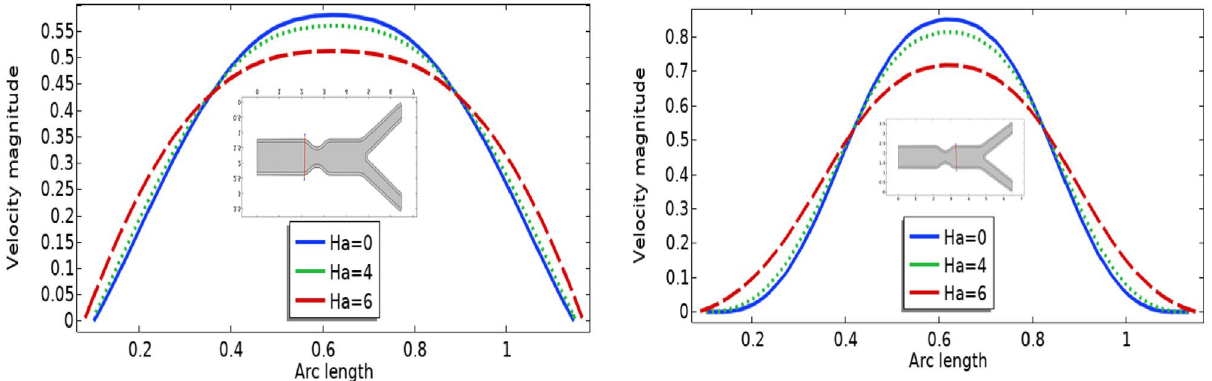
Figure 8. Velocity profile for different Ha.